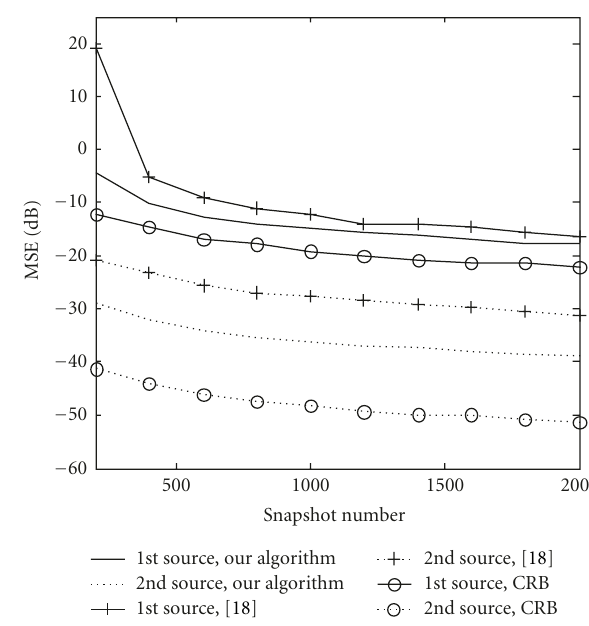
Figure 9: Estimation MSE of the ranges versus snapshot number.